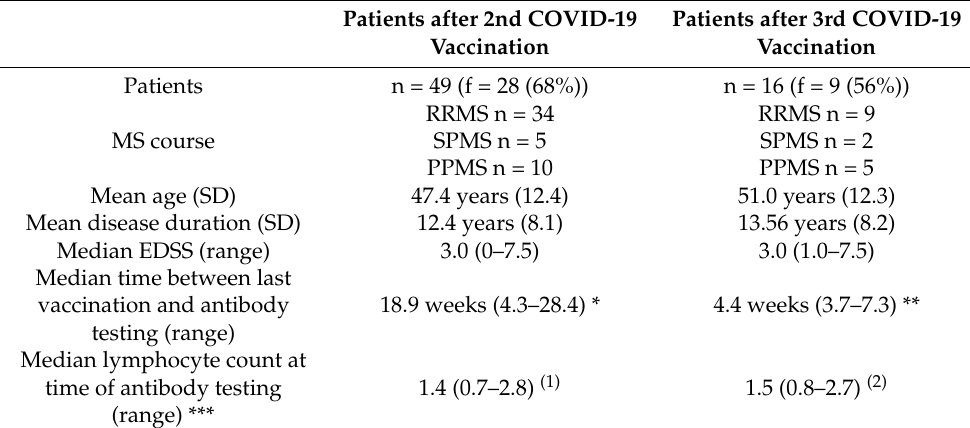
Table legend: f = female; SD = standard deviation; RRMS = relapsing–remitting MS; SPMS = secondary-progressive MS; PPMS = primary-progressive MS; * median time between 2nd vaccination and Spike-protein IgG testing; ** median time between 3rd vaccination and Spike-protein IgG testing; *** normal values: 0.8–4 G/L; (1) n = 44; (2) n =